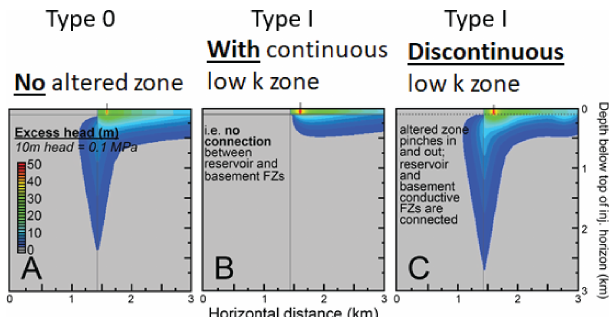
Figure 12. Cross-sectional views of pore pressure envelope propa- gation resulting from injection into a reservoir underlain by a low- permeability altered zone. Excess hydraulic heads after 4 years of constant-rate injection are presented for a Paleozoic conduit-barrier fault scenario. (a) Faulted Type 0 nonconformity with no low- permeability altered zone; (b) Type I nonconformity with an altered zone present as a 20m thick confining layer (represented by two horizontal grey lines) that is continuous such that the reservoir and basement fault zones do not connect; (c) Type I nonconformity with a discontinuous altered zone that pinches in and out in 20m hori- zontal intervals (i.e., undulating) but with the reservoir and base- ment fault zones fully connected. Results are zoomed in to the top 3km × 3km of the model domain. Vertical grey lines indicate the location of the fault zone. The injection well location is indicated on top of each panel. Transition from grey to dark blue (and all subsequent contour lines) denotes a 2m increase in hydraulic head (0.02MPa). Adapted from Ortiz (2017; for details of the modeling approach, see Ortiz et al., 2019).